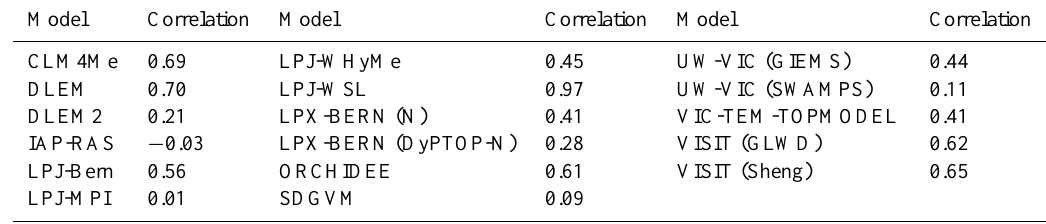
Table 5. Spatial correlations between simulated average annual CH 4 emissions and GIEMS surface water area fraction ( F w ). Model